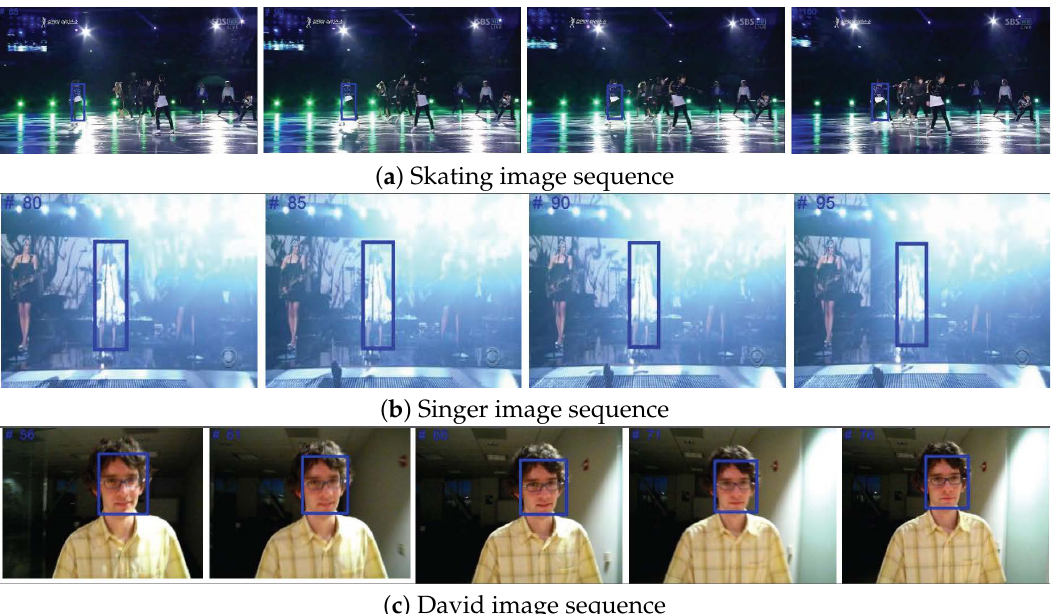
Figure 6. Tracking during illumination changes.